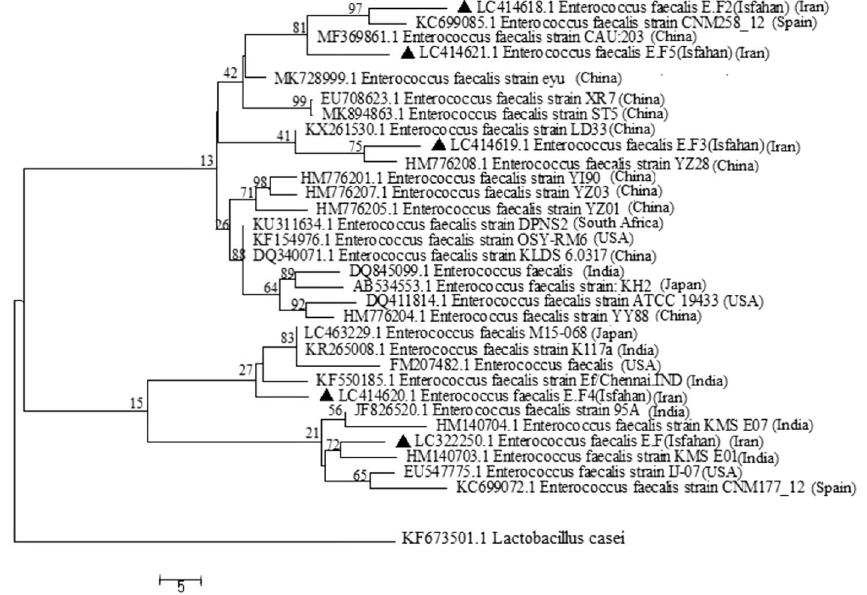
Figure 1. Phylogenetic tree of the E. faecalis isolates based on 16S rRNA sequences. The maximum likelihood tree was built using Lactobacillus casei (KF673501.1) as an out-group with 1000 bootstrap replicates using MEGA 7 software. Branch numbers show bootstrap percentage following 1000 replications. Scale bar corresponds to phylogenetic distance of 0.05 nucleotide change or substitutions per site. ▲ : Indicates E. faecalis isolated in this